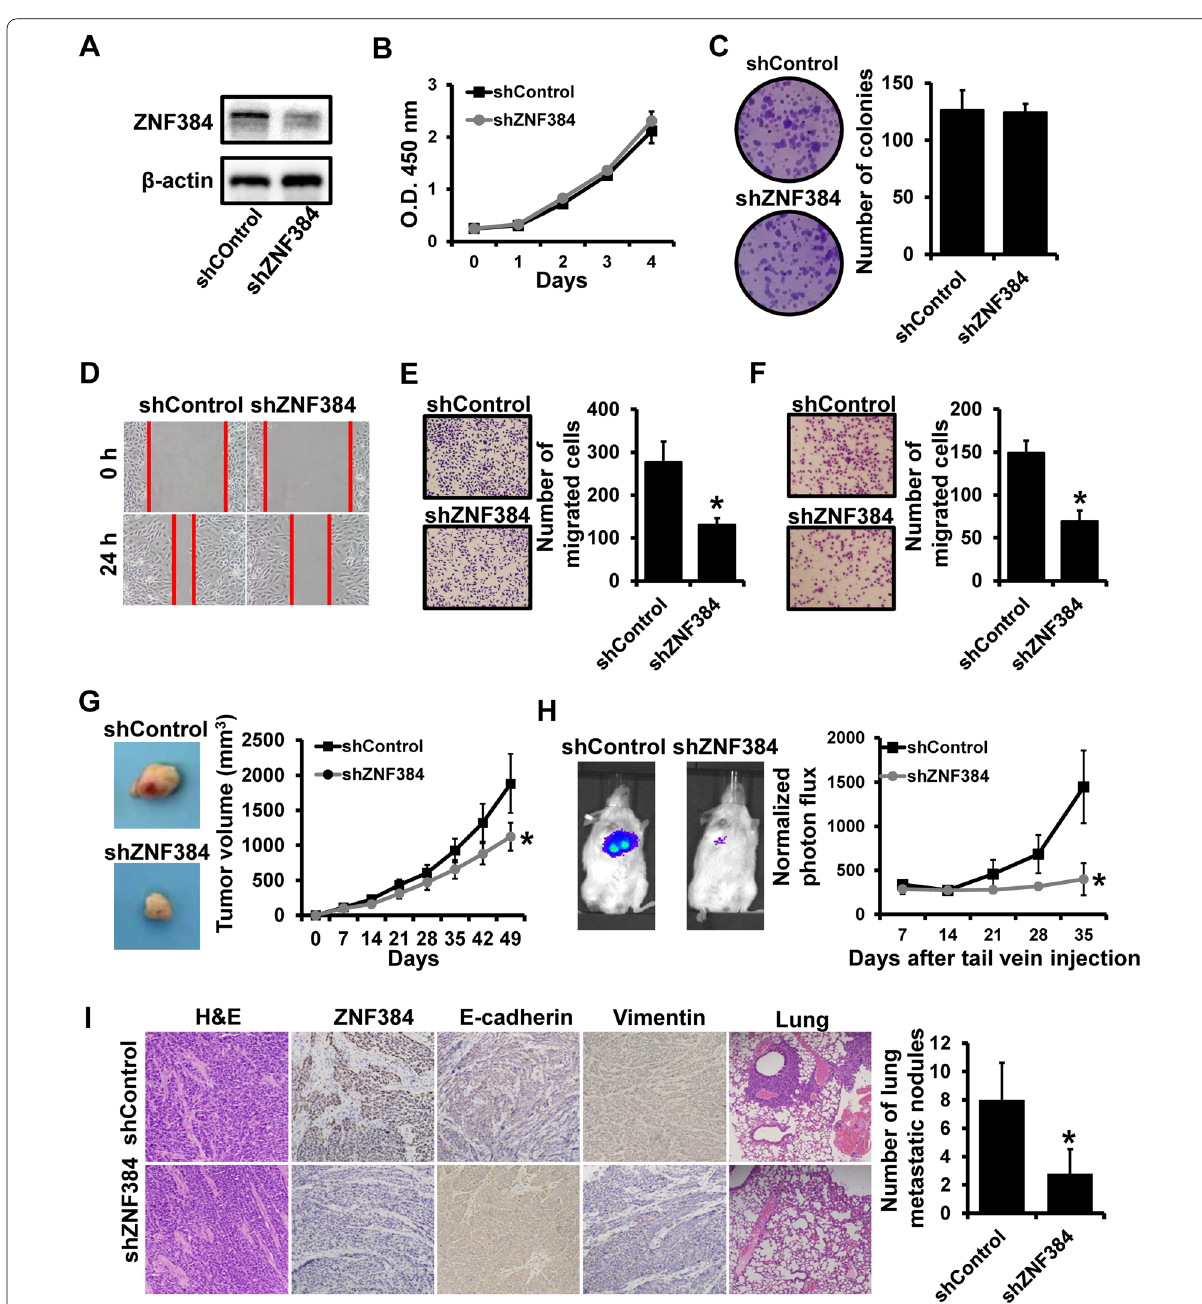
Fig. 3 Depletion of ZNF384 expression suppresses breast cancer metastasis. A ZNF384 expression in stable ZNF384‑depleted cells (shZNF384) and control cells (shControl) determined by western blot. B The ability of cell proliferation of cells as in A determined by CCK‑8. C The clonogenic potential of cells as in A determined by colony formation assays. D–F The ability of cell migration and invasion in cells as in A determined by wound‑healing ( D ) and transwell ( E – F ) assays. G Tumor growth curves for xenograft mice injected with cells as in (A) at the indicated times. H Bioluminescent imaging of metastasis for xenograft mice after tail vein injection of cells as in A . I H&E staining or immunohistochemical staining in primary tumors or metastatic nodules in the lung harvested from mice bearing the indicated xenograft tumors. * P <